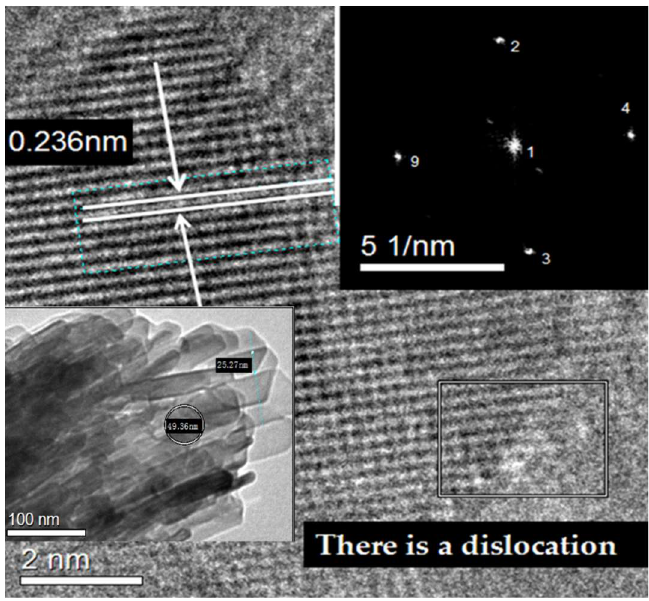
Figure 8. TEM and HRTEM images of MMO.